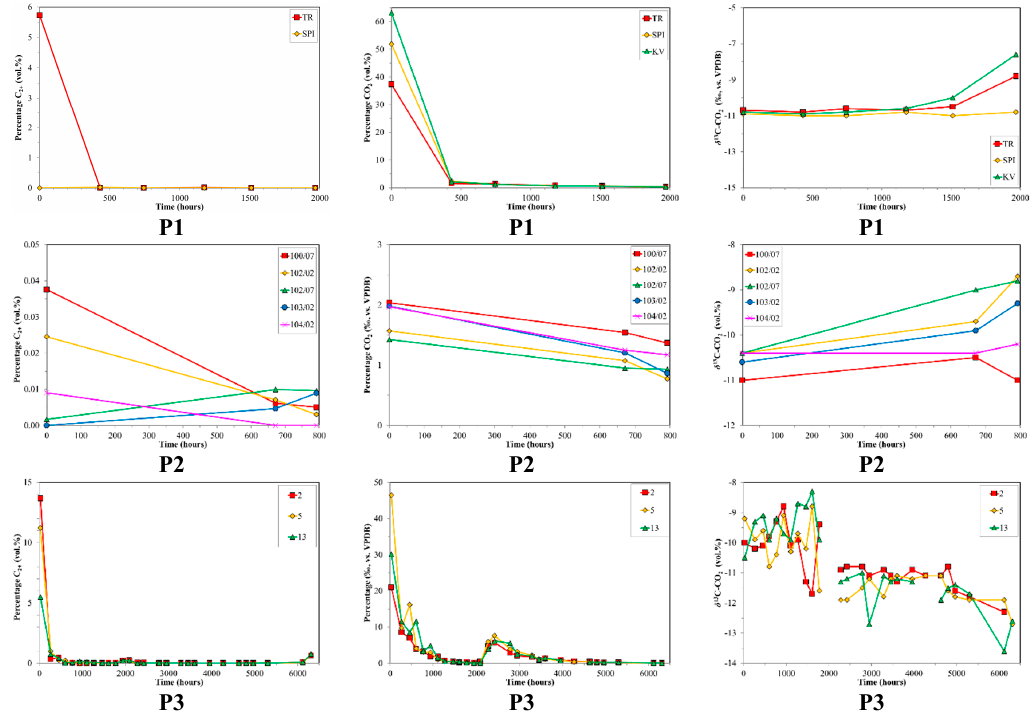
Figure 2. Time series of volume % C 2+ , volume % CO 2 and δ 13 C-CO 2 for production sample sets P1, P2 and P3 versus production time. The 0 h value corresponds to the first samples collected. Note the different scales between production sample sets.